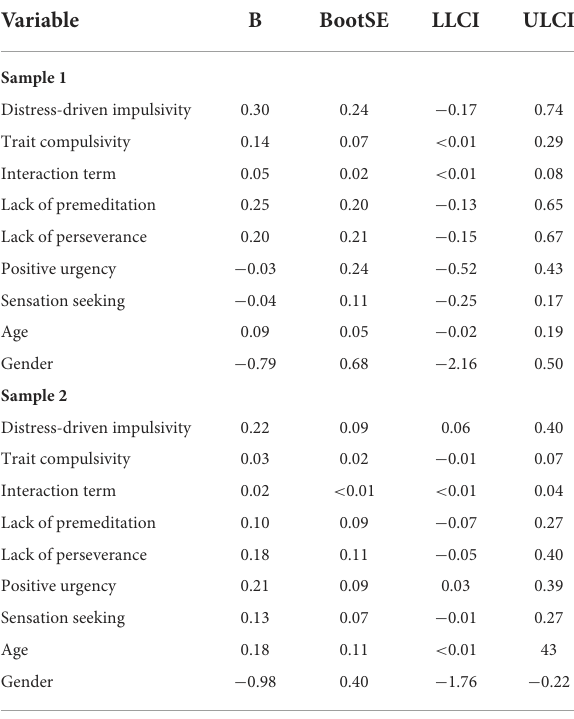
TABLE 3 Results of bootstrapped moderation